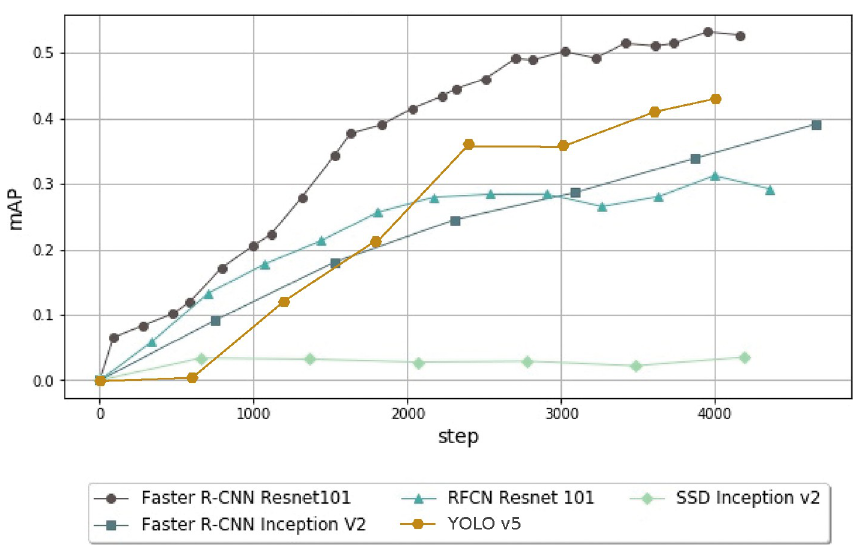
Fig 5. Performance comparison using the mAP of the object-detection models trained using various meta- architectures (Faster R-CNN, SSD, YOLO and RFCN) for 4,000 steps. Faster algorithms such as SSD cannot deal with the complexity of the problem. Faster R-CNN emphasizes accuracy over speed and can achieve over six times better performance than SSD with the same feature extractor. YOLO v5, the last version of YOLO, outperforms SSD and RFCN, but Faster R-CNN still has an advantage of 0.1 mAP at 4,000 steps.